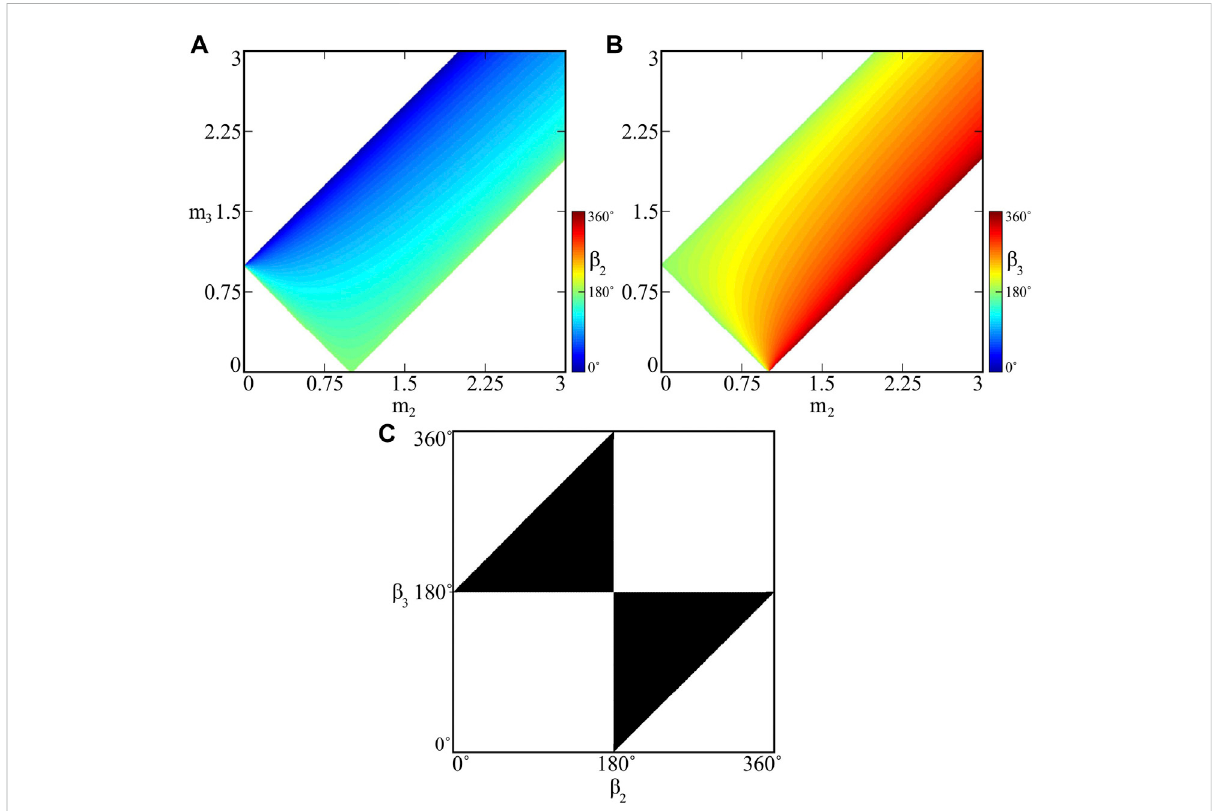
FIGURE 6 (Colouronline).Thevaluesofthephaseswithinthephase – lockedsynchronizationpatternsfor fi xed m 1 =1.0[kg]andvaried m 2 , m 3 :valuesof β 2 and β 3 are shown in panels (A) and (B) , respectively. The possible phases β 2 , β 3 , which can be realized by model (1) due to the solvability of system (8) are shown in (C) . The results determine regions, where particular types of behaviours can be found, as well as their